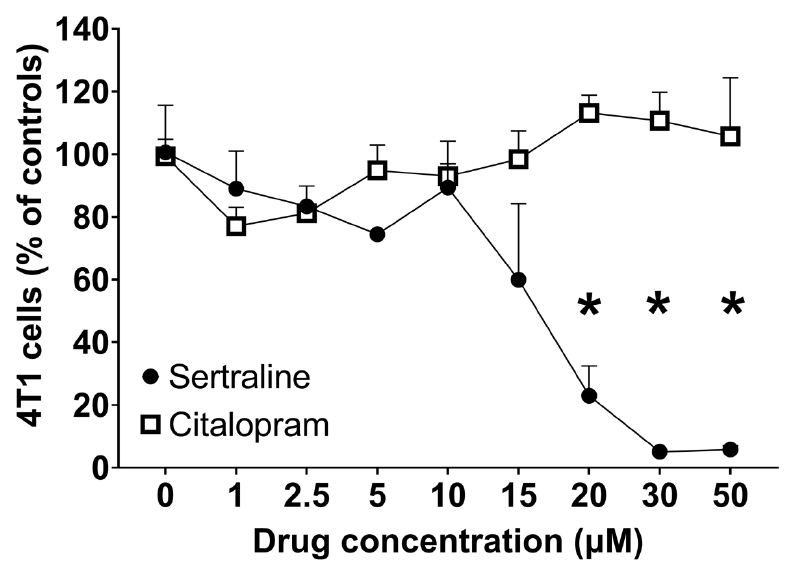
Figure 1. Effect of various concentrations of SSRIs on 4T1 cell viability — Points represent Mean ± SE of 3 separate experiments, expressed as % of controls. Viability was assessed by Neutral Red following 24 h incubation under normal conditions (no starvation). * p < 0.05 vs. basal.